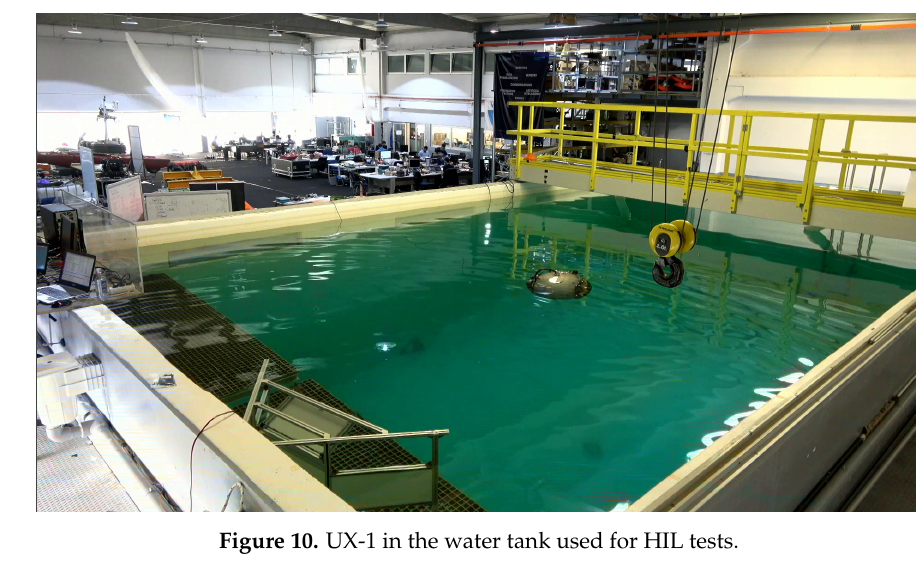
Figure 10. UX-1 in the water tank used for HIL tests.